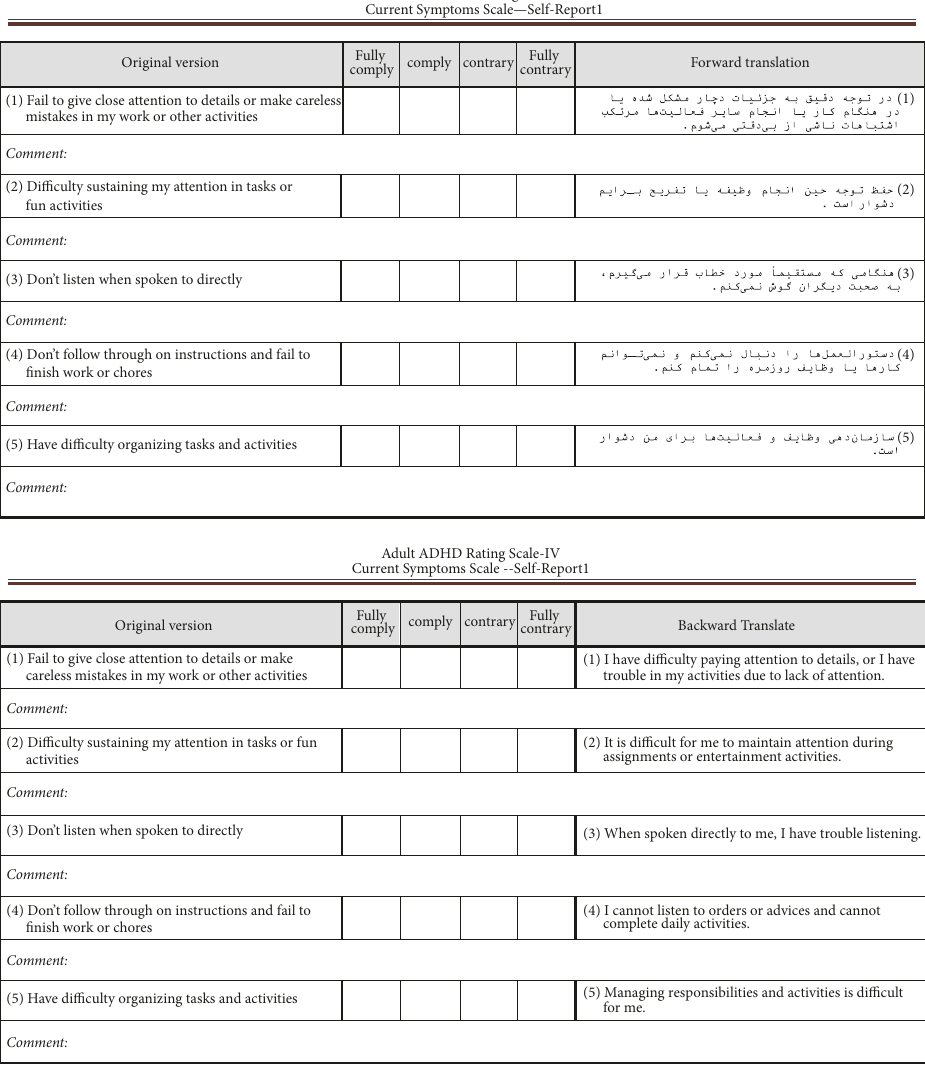
the scale capability for sound measurement with adequate psychometric